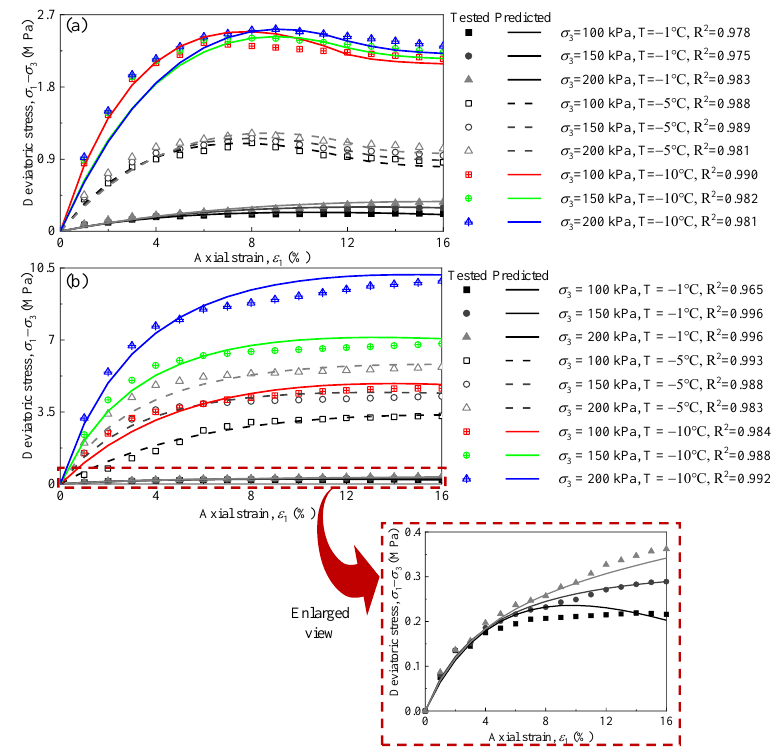
Figure 9. Comparison of the predicted and tested data of the tested remoulded fine-grained materials: ( a ) sand and ( b ) silty clay.